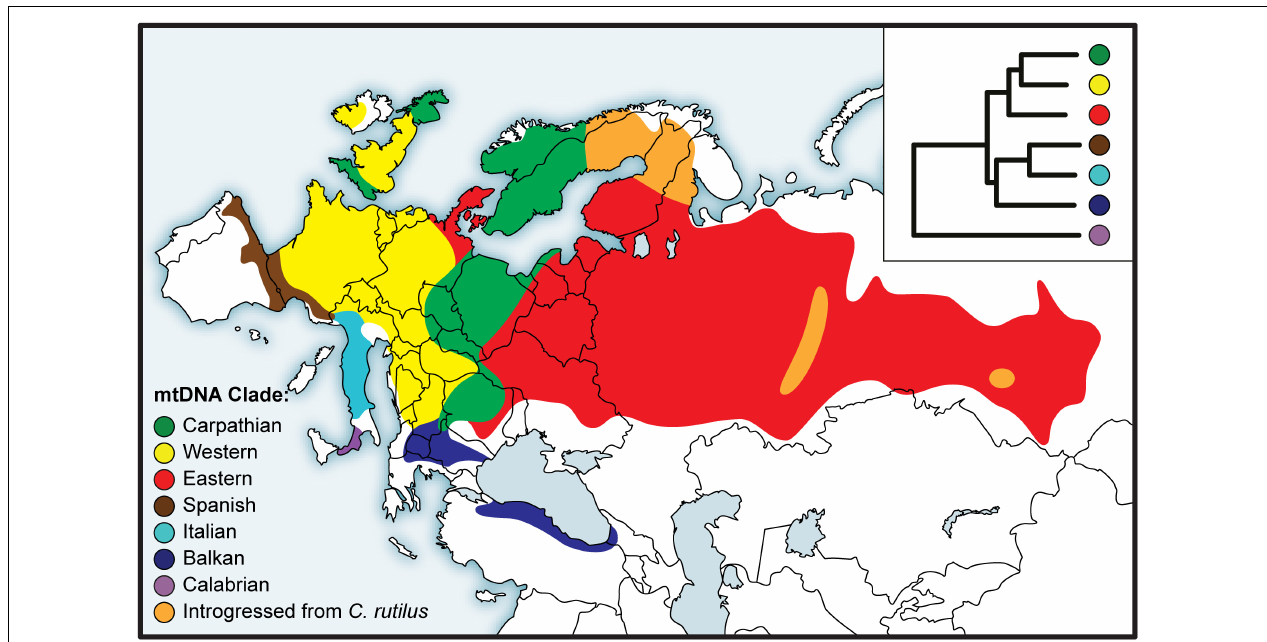
FIGURE 3 | Distribution of bank vole phylogeographic clades inferred from mitochondrial (mt) DNA sequences, with a schematic representation of the phylogeny in the inset top right (adapted from Filipi et al.,